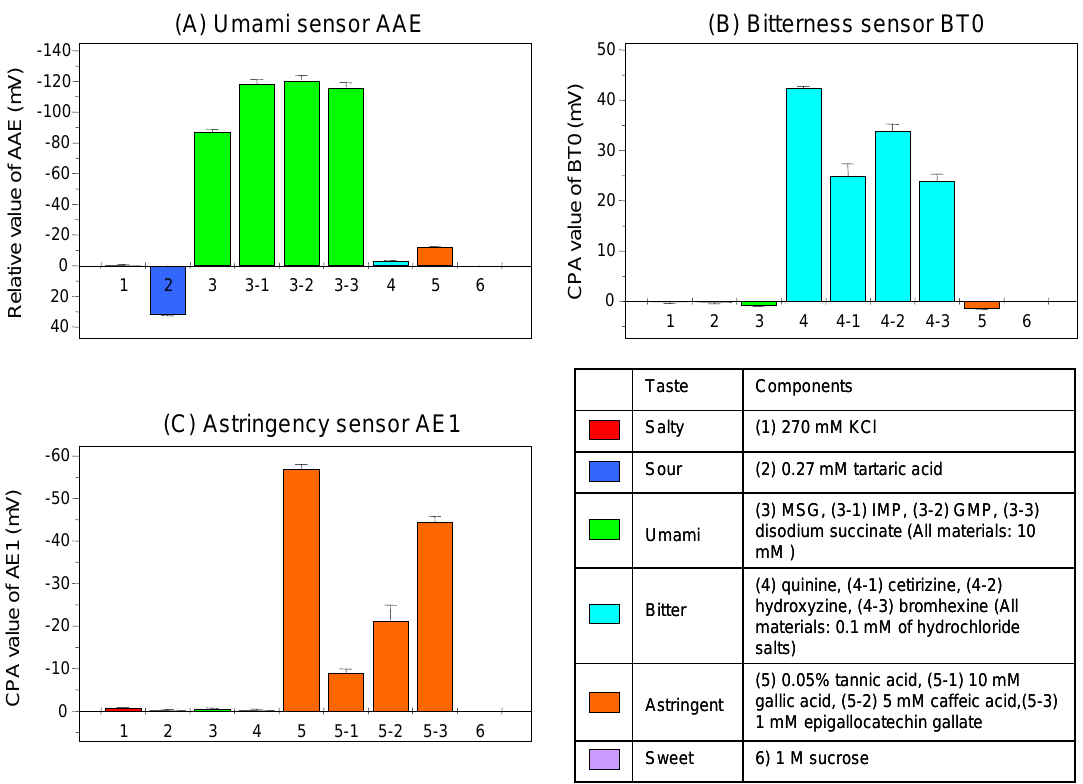
Figure 11. Responses of taste sensors to six tastes. Figure 11A uses the relative value of the umami sensor AAE; Figure 11B, the CPA value of the bitterness sensor BT0;